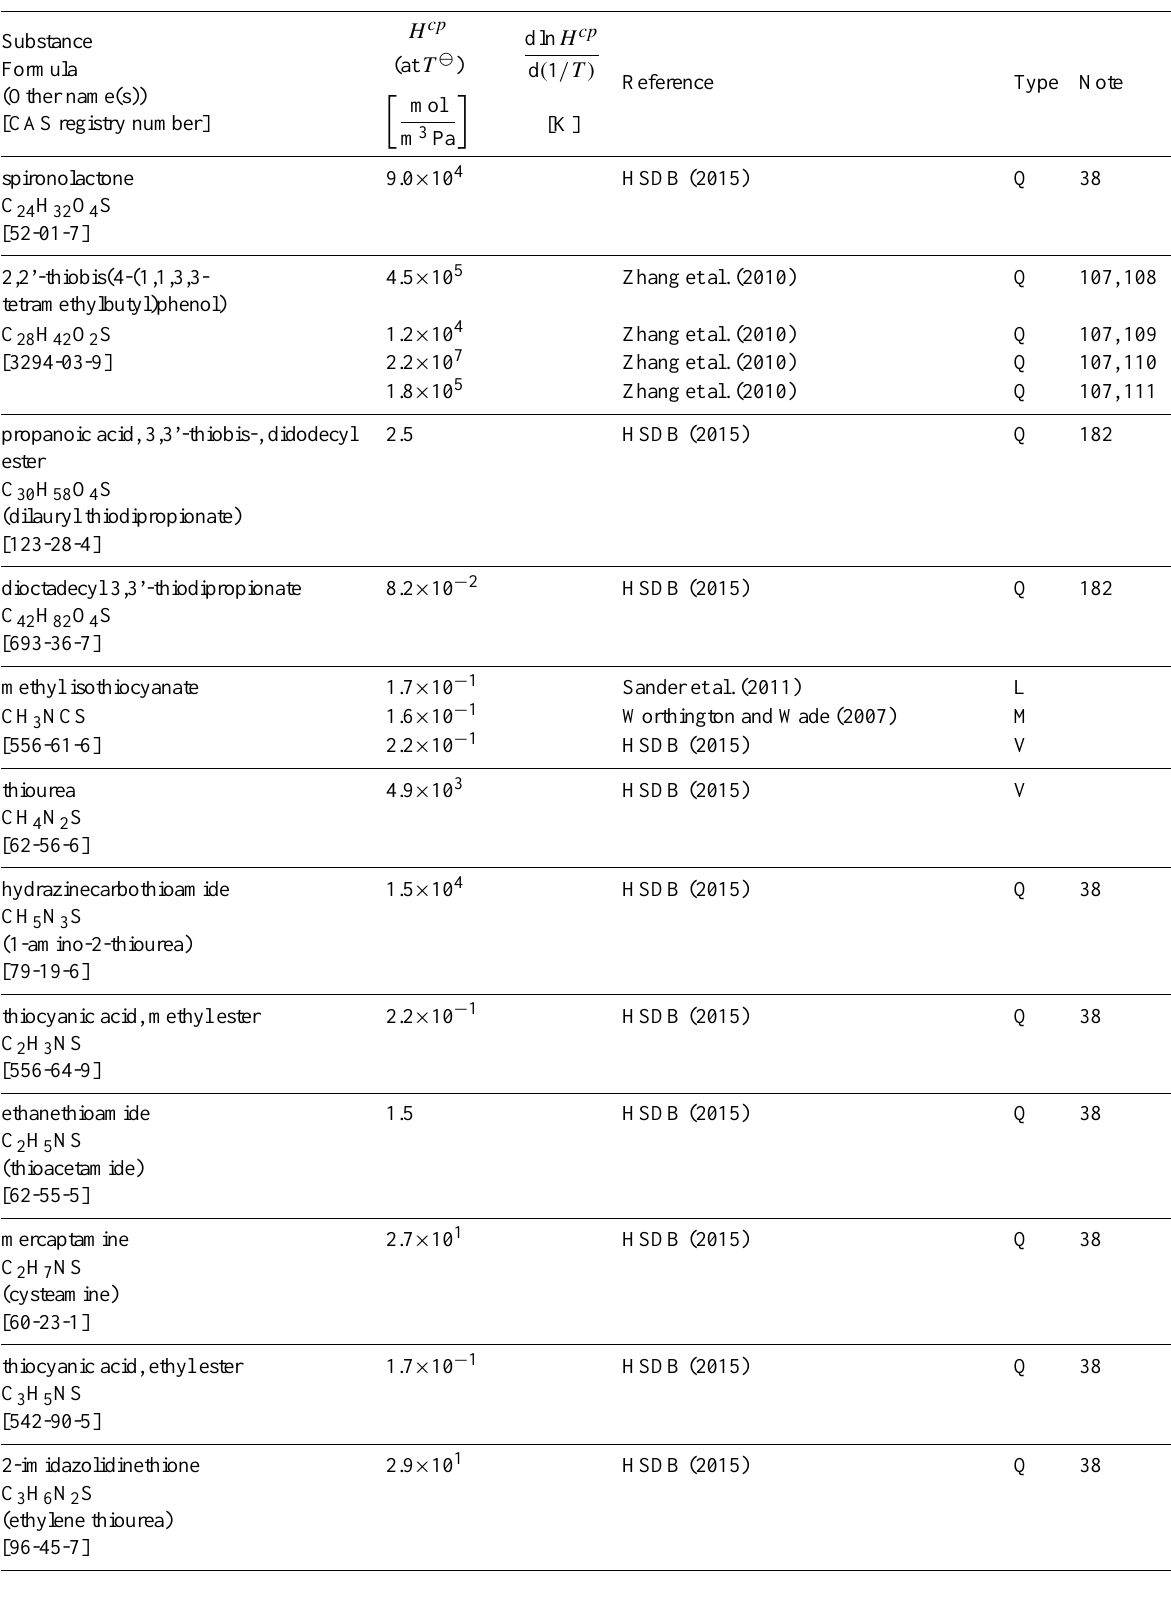
Table 6: Henry’s law constants for water as solvent